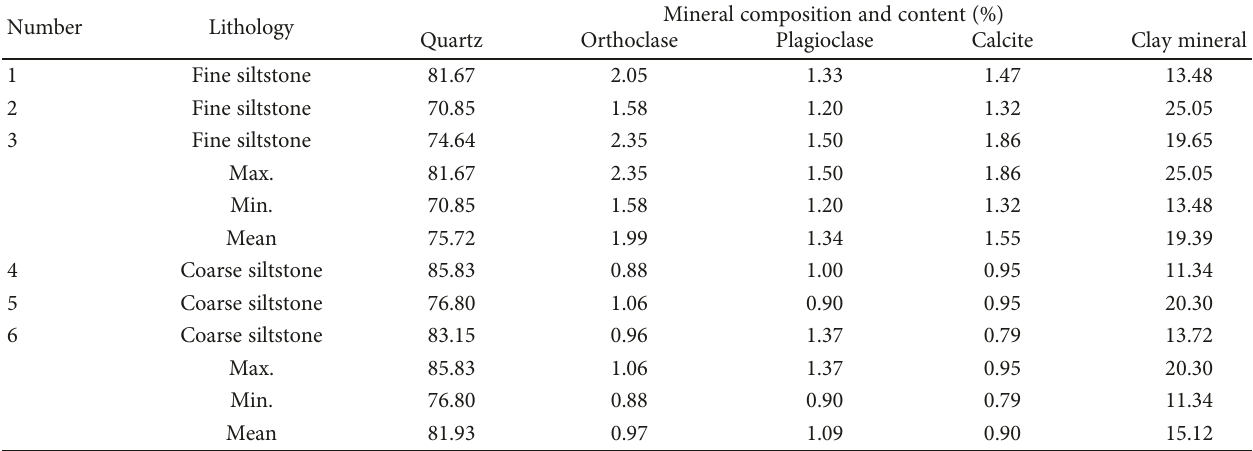
Table 1: Main mineral composition and